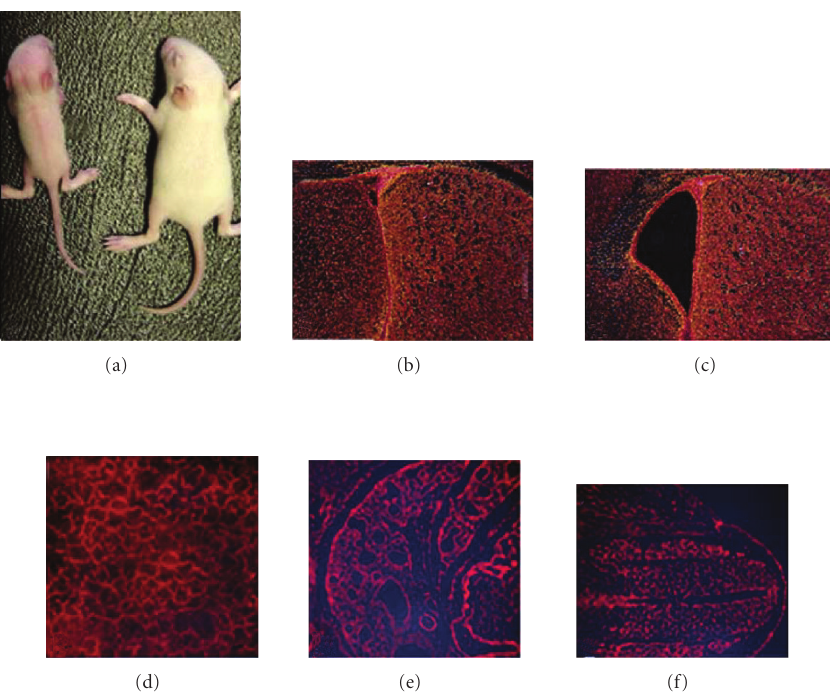
Figure 8: Longevity of the RNAi. (a) Day 10 neonatal mice (PN10) obtained from litters exposed on E6.5 to the Bmp4 shRNA (left) or to pRed (no hairpin plasmid) control (right). Bmp4 shRNA mice were consistently developmentally delayed and lacked testis or ovaries. (b) and (c) Coronal sections through the lateral ventricles of PN3 mice exposed on E17.5 to pRed control (b) or to Bmp4 shRNA (c). In addition to the obvious anomalies of the subventricular zone and ventricle, neural stem cells obtained from the Bmp4 shRNA mice fail to di ff erentiate normally. (d)–(f) illustrate the persistent expression of DsRed in liver (d), lung (e), and spinal cord (f) in neonates exposed to Bmp4 shRNA on